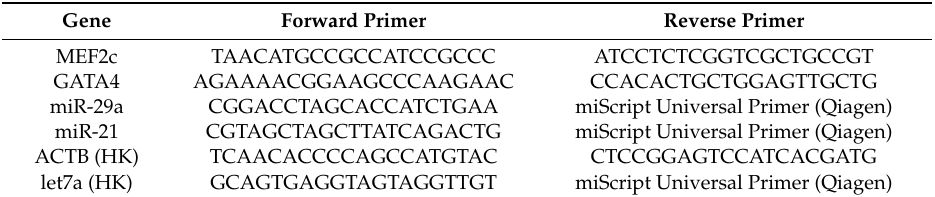
Table 2. Primer list of genes used for mRNA and miRNA gene expression to evaluate hypertrophy stimulation. Housekeeping genes are abbreviated with